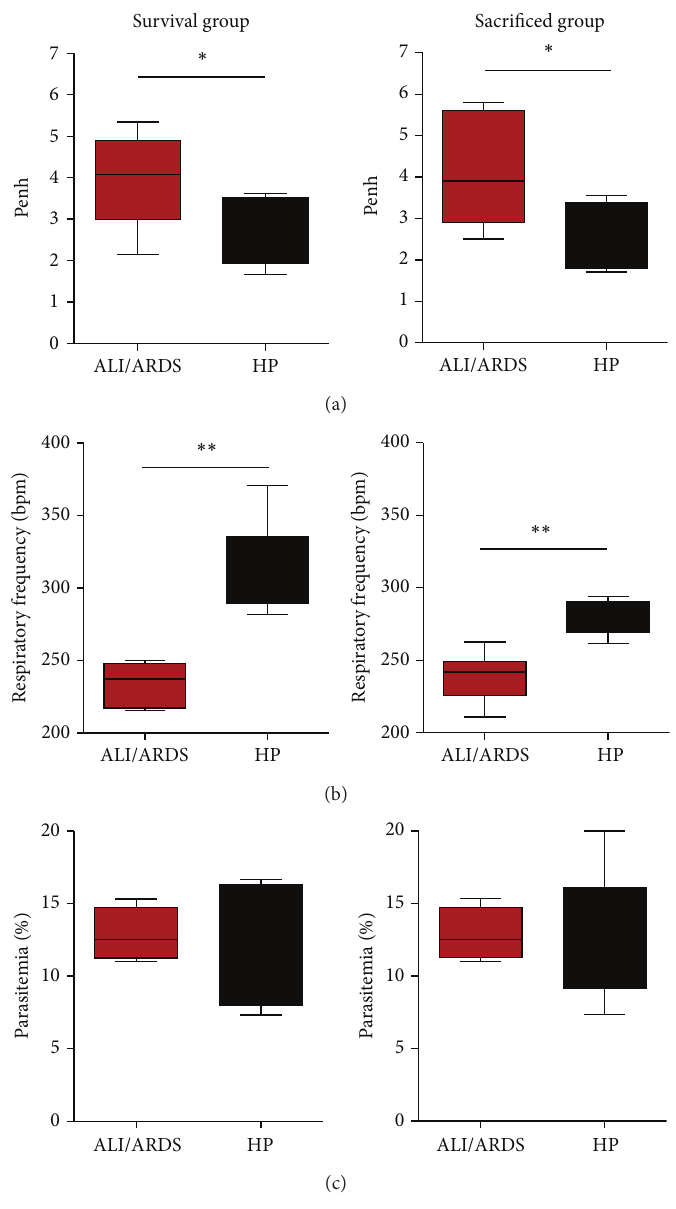
Figure5:Amurinemodeltopredictmalaria-associatedALI/ARDS.(a)Penh(enhancedpause),(b)respiratoryfrequency,and(c)parasitemia measured on the 7th DAI. The sacrificed mice were classified according predictive model, using the parameter cut-offs measured from the survival mice and applied to the sacrificed mice. DBA/2 mice infected with P. berghei ANKA and their breathing parameters were measured in plethysmographchambers(BUXCOElectronics,USA).Notethatthesethreeparametersaresimilarbetweenthesurvivalgroupandsacrificed group; ( 𝑛 = 11 mice/group; ∗ 𝑃 < 0.05 , ∗∗ 𝑃 < 0.005 , Mann-Whitney test). ALI/ARDS: acute lung injury/acute respiratory distress